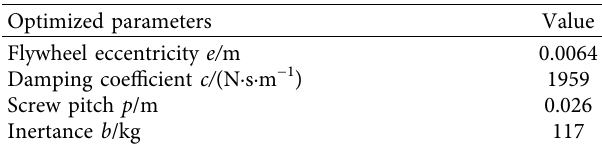
Table 3: Optimal parameters of suspensions with a parallel-con- nected eccentric